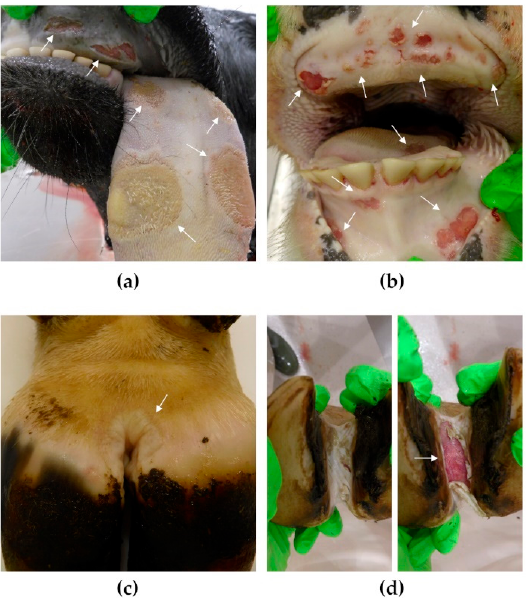
Figure 4. Postmortem findings after injection of naked FMDV RNA into the tongue. All six cattle in the first animal trial developed severe clinical signs of FMD and pathognomonic findings were made at necropsy (arrows): ( a ) lesions on the tongue, corresponding to the areas of injection, and on the upper gums; ( b ) lesions on the tongue, the upper and lower gums; ( c ) large, mostly intact lesion in the interdigital space; ( d ) the true extent of the lesion is revealed after manipulation.